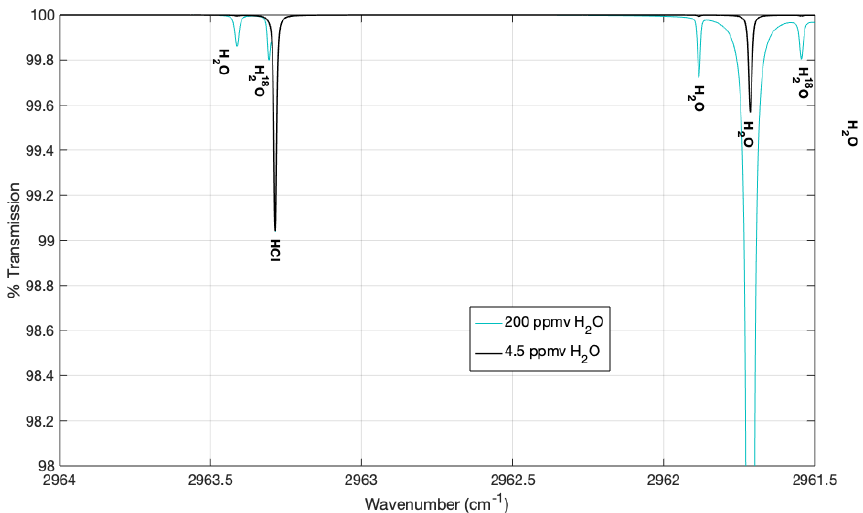
Figure 2. Theoretical spectrum in the vicinity of the HCl feature. Parameters are P = 53hPa, T = 310K, HCl = 1.0ppbv, and H 2 O = 4.5ppmv (black) and 200ppmv (blue). P and T are in the range of what was observed in flight, and mixing ratios in black are representative of the